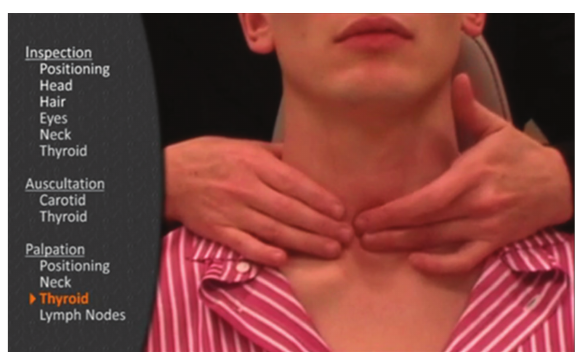
Figure 3: Video examples allow visual learners to develop their physical examination